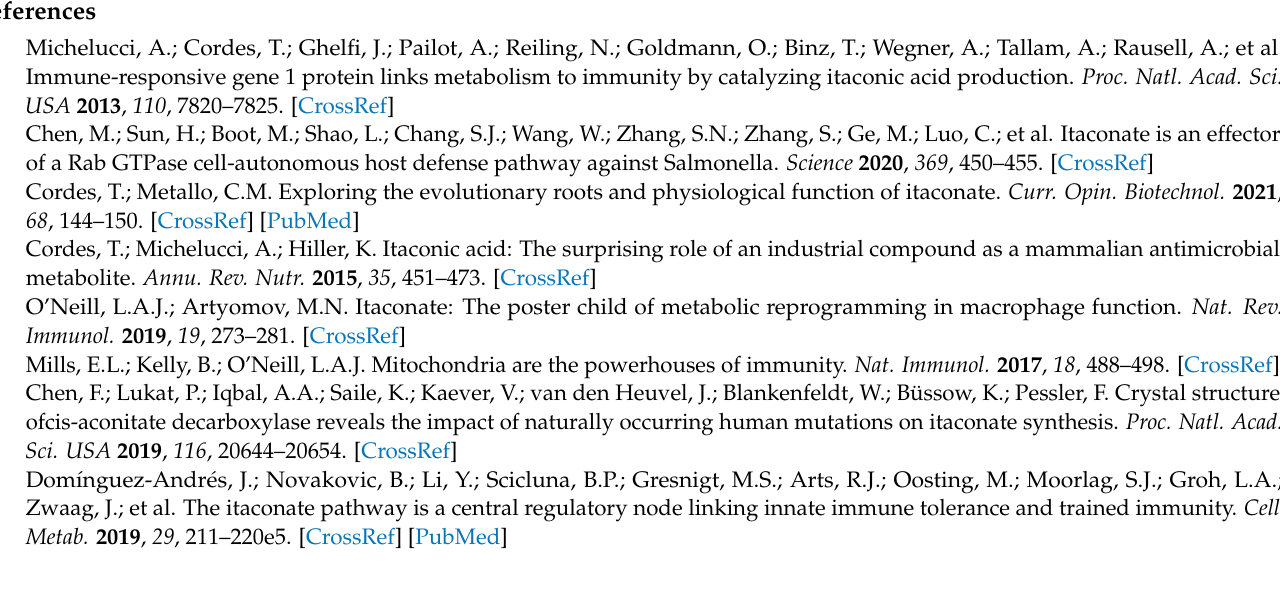
Figure S4: Itaconate influences methylmalonyl-CoA mutase activity, Figure S5: Itaconate alters fatty acid metabolism, Figure S6: LC-MS spectra of CoA and carnitine